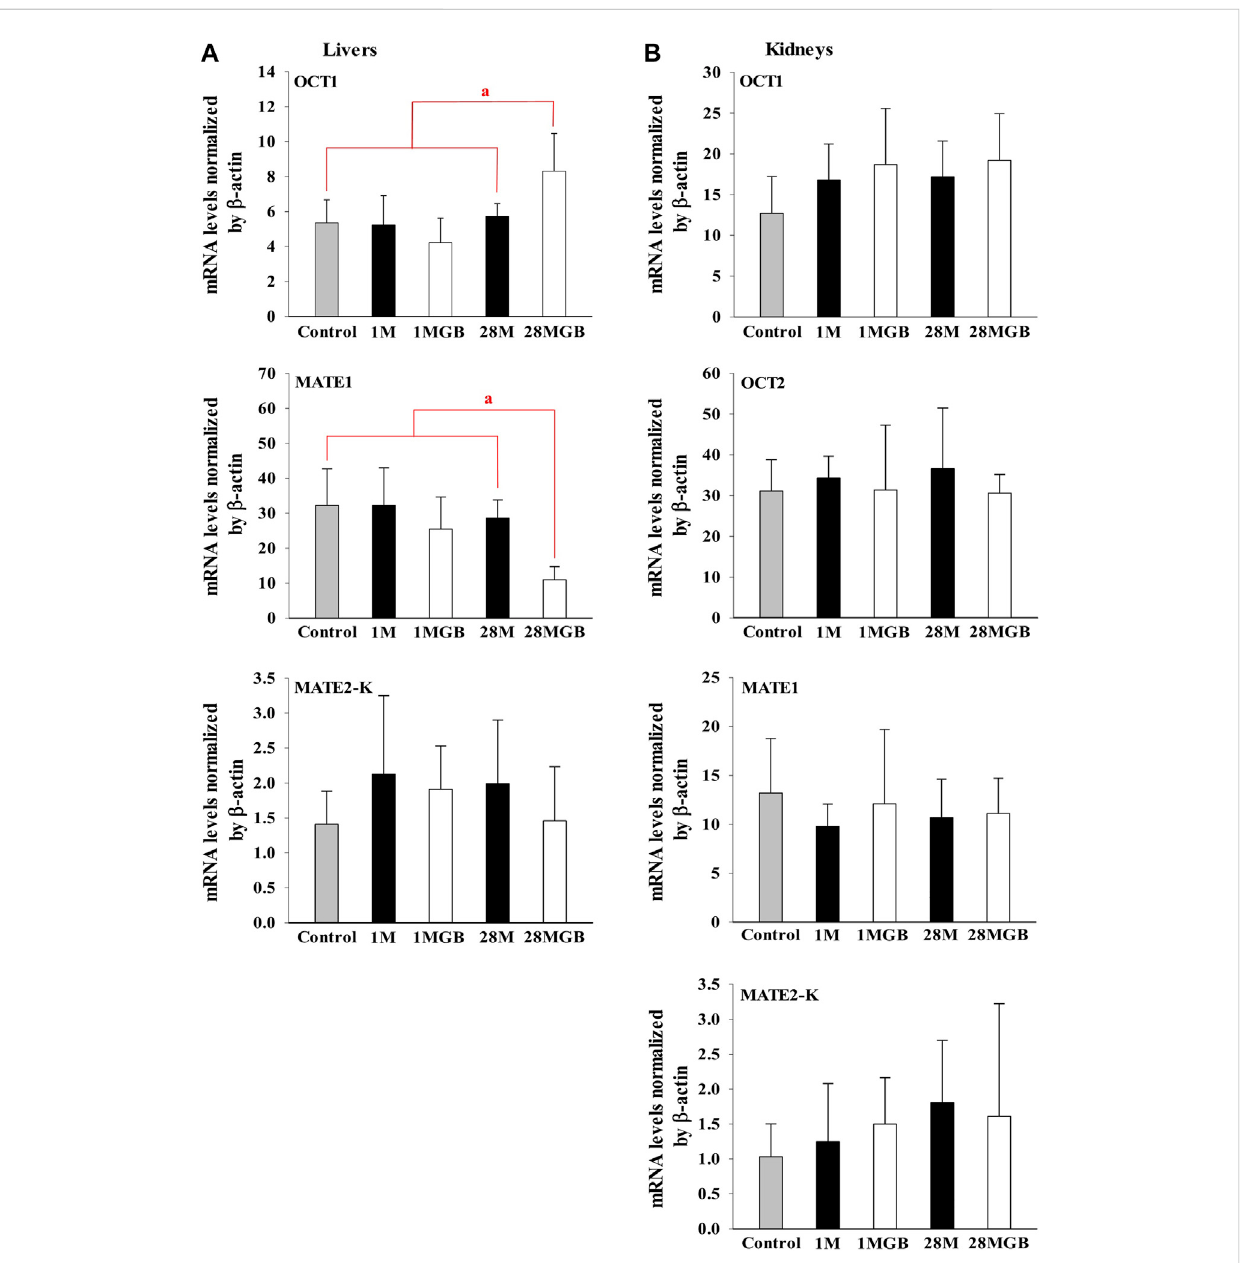
FIGURE 3 Relative mRNA expressions of OCT1, OCT2, MATE1 and MATE2-K in (A) livers and (B) kidneys of control, 1 M, 1 MGB, 28 M and 28 MGB groups, respectively. a 28 MGB was signi fi cantly different ( p < 0.05) from other groups.